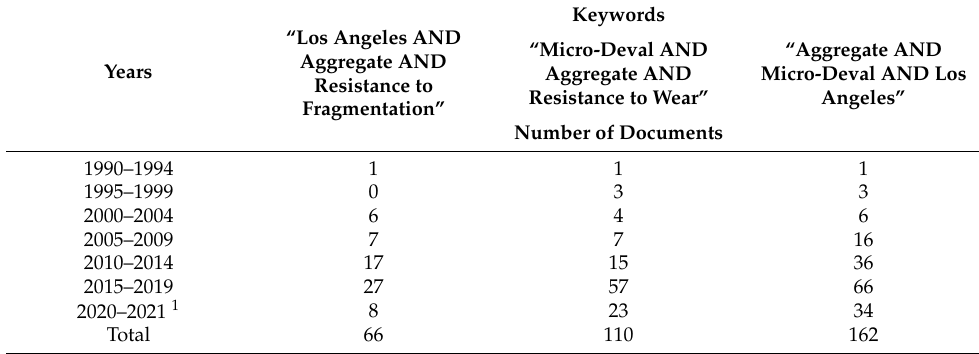
Table 1. Keywords and search